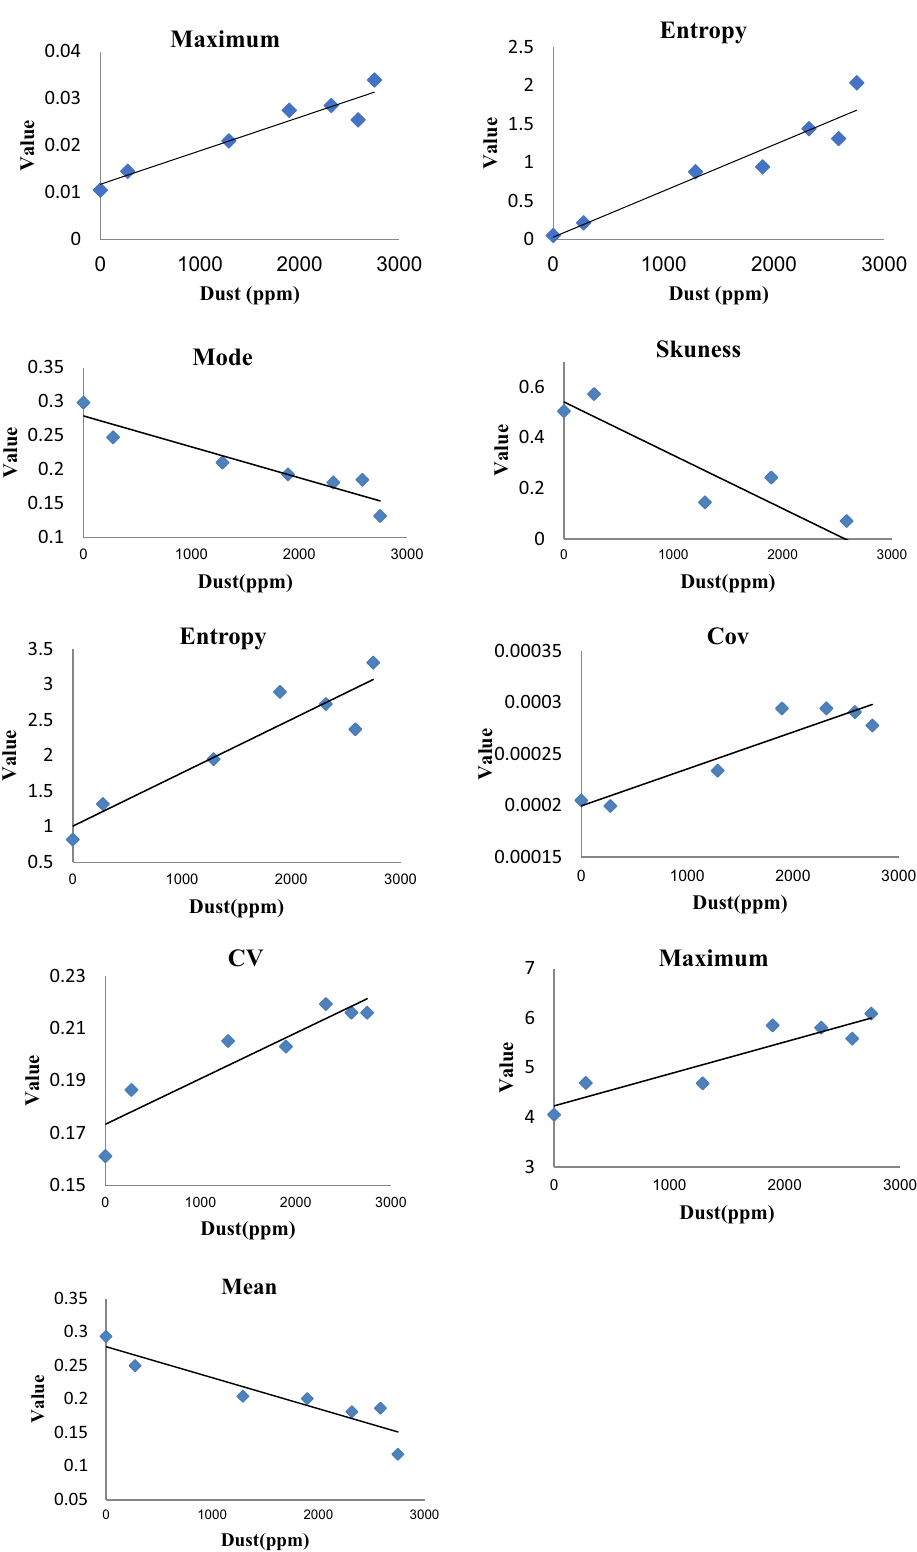
Figure 1. Single variable linear model for predicting dust concentration based on maximum of Cr, entropy of Cr, mod of H, skewness of I3, Entropy of L*, covariance of S, coefficient of variation of H, maximum of b* and mean of H